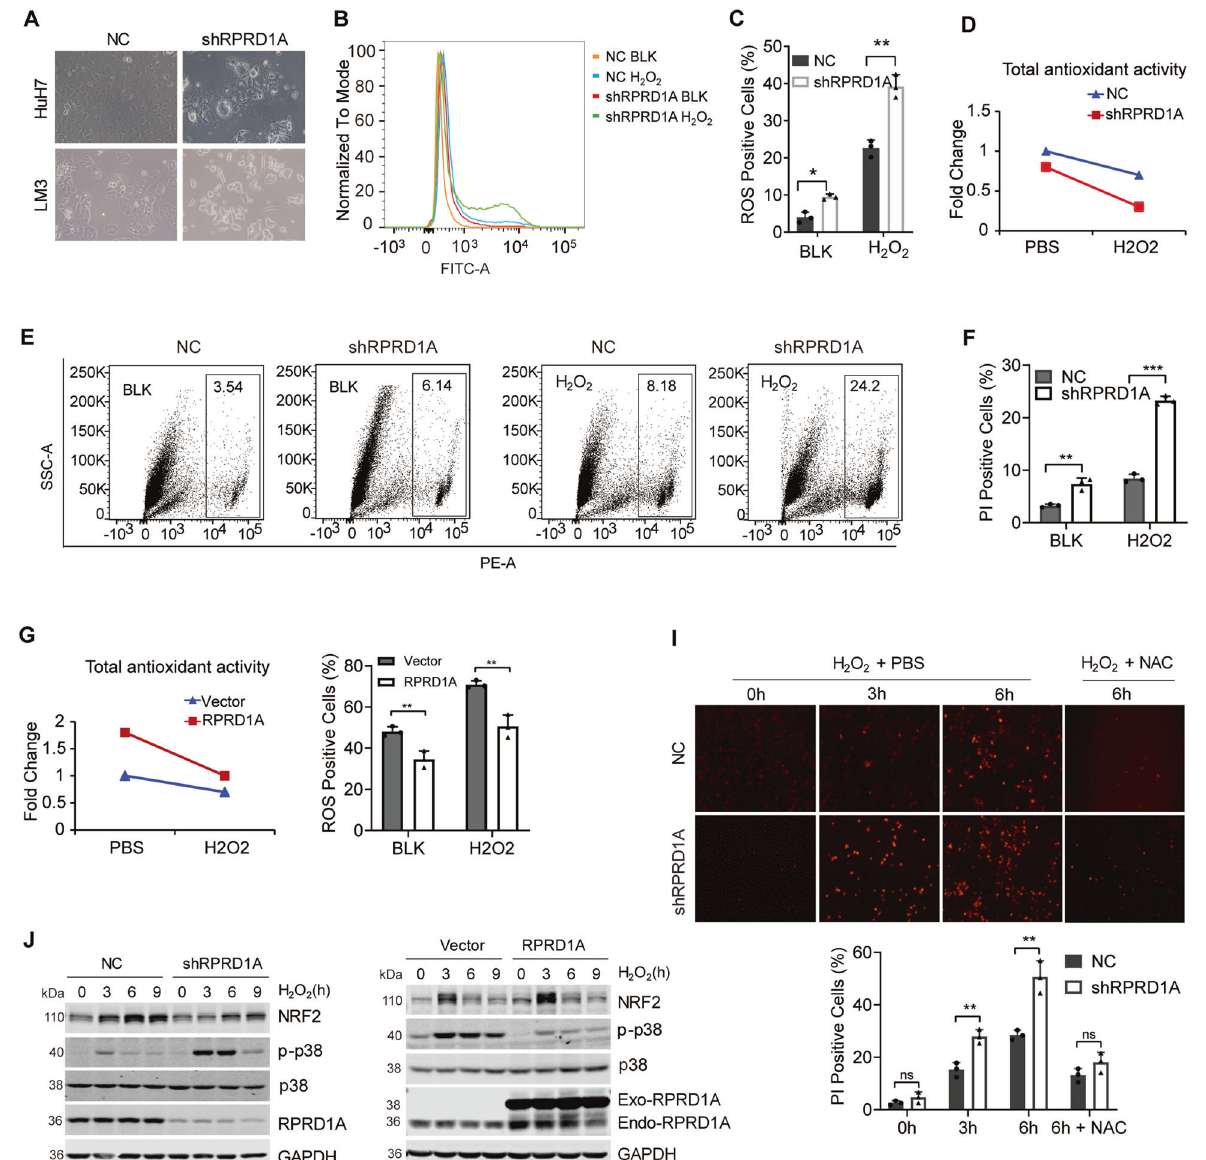
Fig. 3 RPRD1A decreases the intracellular ROS level and enhances the capacity to cope with oxidative stress. A Optical microscope pictures of Huh7 and MHCCLM3 cells transfected with shRPRD1A and control lentivirus for 72 h. B Analysis of ROS levels by fl ow cytometry in MHCCLM3-NC and -shRPRD1A cells treated with 0.5 mM H 2 O 2 for 4 h. C , Quanti fi cation of the ROS levels in ( B ). D Total antioxidant capacity was measured with a T-AOC assay kit in MHCCLM3-NC and -shRPRD1A cells treated with 0.5 mM H 2 O 2 or PBS for 4 h. E ROS-mediated cell death was determined by fl ow cytometry. MHCCLM3-NC and -shRPRD1A cells were treated with 0.5 mM H 2 O 2 for 9 h, and stained with PI for 20 min. The number of PI-positive cells was then observed and quanti fi ed. F Quanti fi cation of cell death in ( E ). G Total antioxidant capacity was measured with a T-AOC assay kit in RPRD1A overexpressed and control MHCCLM3 cells treated with 0.5 mM H 2 O 2 or PBS for 4 h. H Quanti fi cation of the ROS levels in RPRD1A overexpressed and control MHCCLM3 cells treated with 0.5 mM H 2 O 2 for 4 h by fl ow cytometry. I PI staining analysis and quanti fi cation in MHCCLM3-NC and -shRPRD1A cells treated with 0.5 mM H 2 O 2 or 0.5 mM H 2 O 2 plus 100 nM NAC for the indicated time. J Western blotting detected the expression of RPRD1A, NRF2, p-p38, and p38 in RPRD1A knockdown and overexpressed MHCCLM3 cells treated with 0.5 mM H 2 O 2 for the indicated time. The p values were determined by a two-tailed t-test. * p < 0.05, ** p < 0.01, *** p < 0.001, ns, not signi fi cant. Results are representative of at least three independent